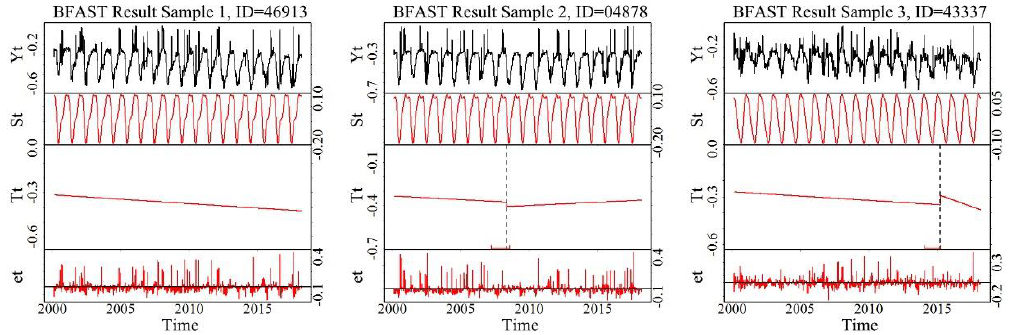
Figure 5. Plots of NDWI time series and BFAST-decomposed seasonal, trend, and remainder components and BFAST-detected break points of samples in land areas. These sampled plots showed that the values in trend component after the break points (if detected) are lower than those in land-to-water pixels.